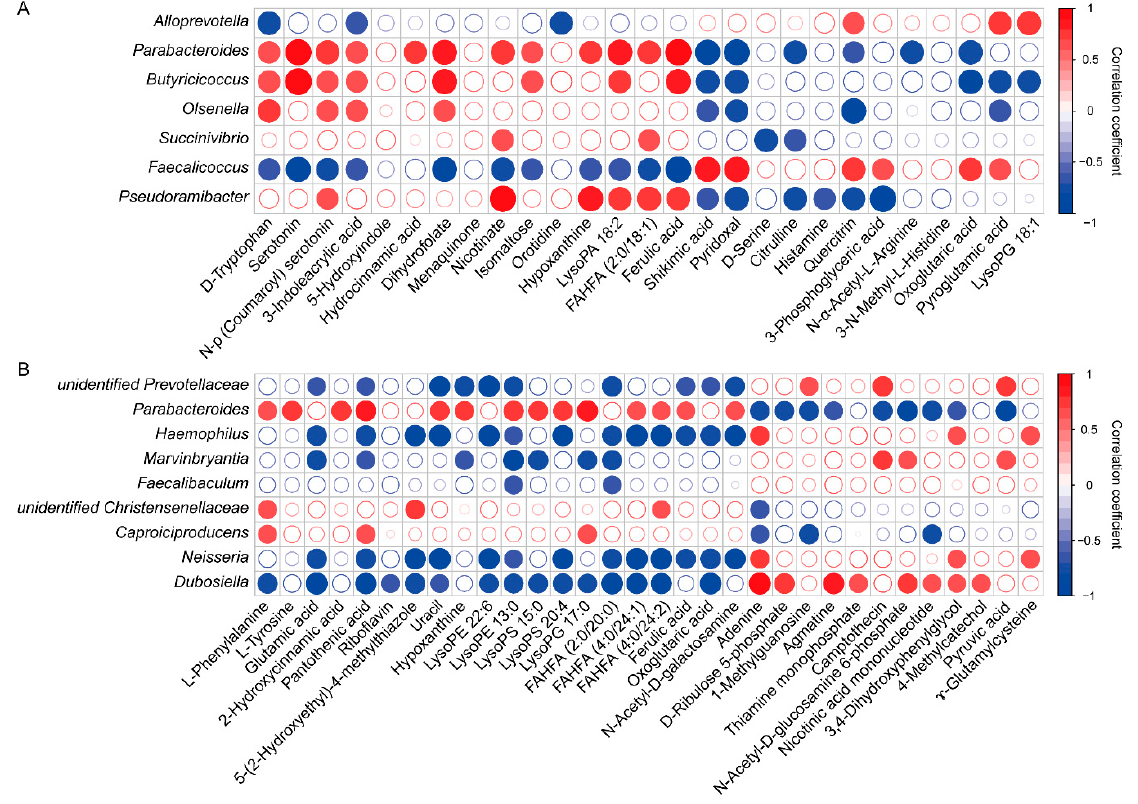
Figure 4. Correlation between the colonic microbiota (at the genera level) and metabolites during the protein restriction ( A ) and realimentation phase ( B ). The circle border color is based on the Spearman correlation coefficient distribution, and its size is based on the correlation coefficient value. The red-filled circle represents a significant positive correlation ( p < 0.05), the blue-filled circle represents a significant negative correlation ( p < 0.05) and the white-filled circle represents no significant correlation ( p > 0.05).